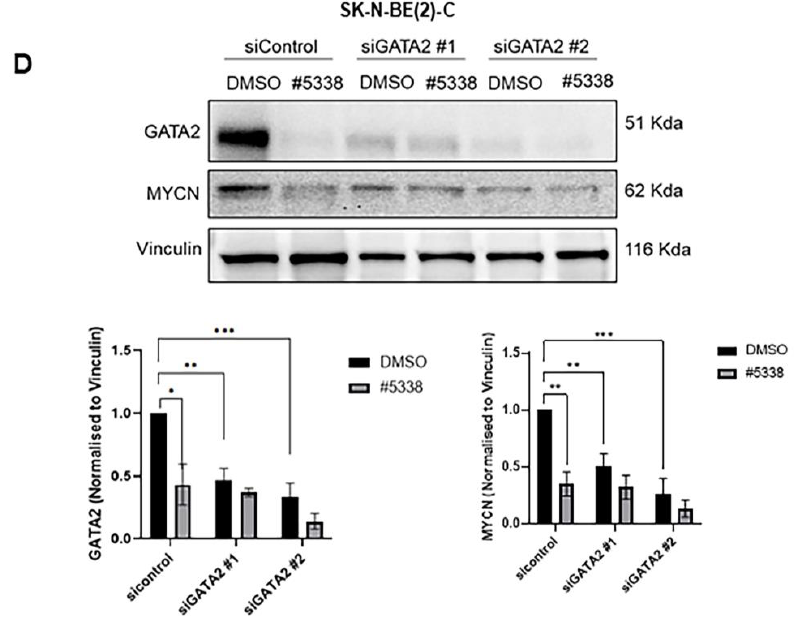
Figure 5. GATA2 as a downstream target for anti-cancer effects of #5333 and #5338. ( A ) Representative Western blot analysis for GATA2 and MYCN expression in Kelly and SK-N-BE(2)-C cells treated with #5333 or #5338 at IC50 concentrations for 72 h. ( B ) SK-N-BE(2)-C cell viability was measured after transfected with siRNA control and two GATA2 siRNAs (siRNA#1 and #2) for 96 h, and treated with #5333 (26.5 μM) or #5338 (23.3 μM) for 72 h using Alamar Blue assay. ( C , D ) Immunoblot analysis of GATA2, MYCN, and control Vinculin expression in SK-N-BE(2)-C after transfection with siRNA control or two GATA2 siRNAs (siRNA#1 and #2) for 96 h, and treatment with #5333 ( C ) or #5338 ( D ) for 72 h. The uncropped blots are shown in Supplementary Materials of original Western Blot figures. “*” is p value < 0.05, “**” is p value < 0.01 and “***” is p value < 0.001 when compared